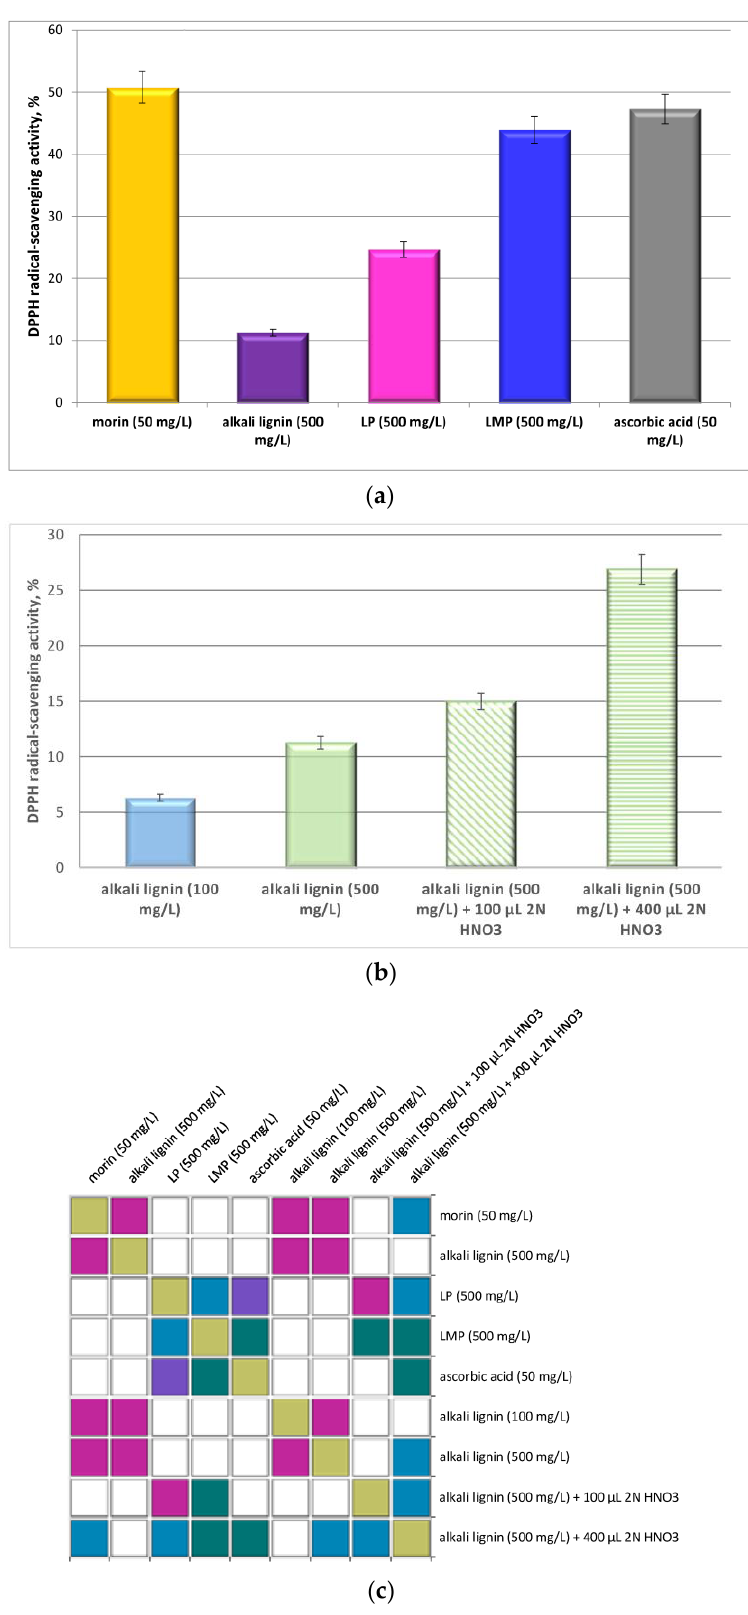
Figure 7. DPPH radical - scavenging activity, % (±SD). ( a ) DPPH activity of LPs, LMPs and pure substances. ( b ) Effect of nitric acid on the DPPH activity of alkali lignin. ( c ) p - values map: yellow— p = 0; purple— p < 0.05; violet— p < 0.08; turquoise— p < 0.15; blue— p < 0.3; white— p < 0.5.